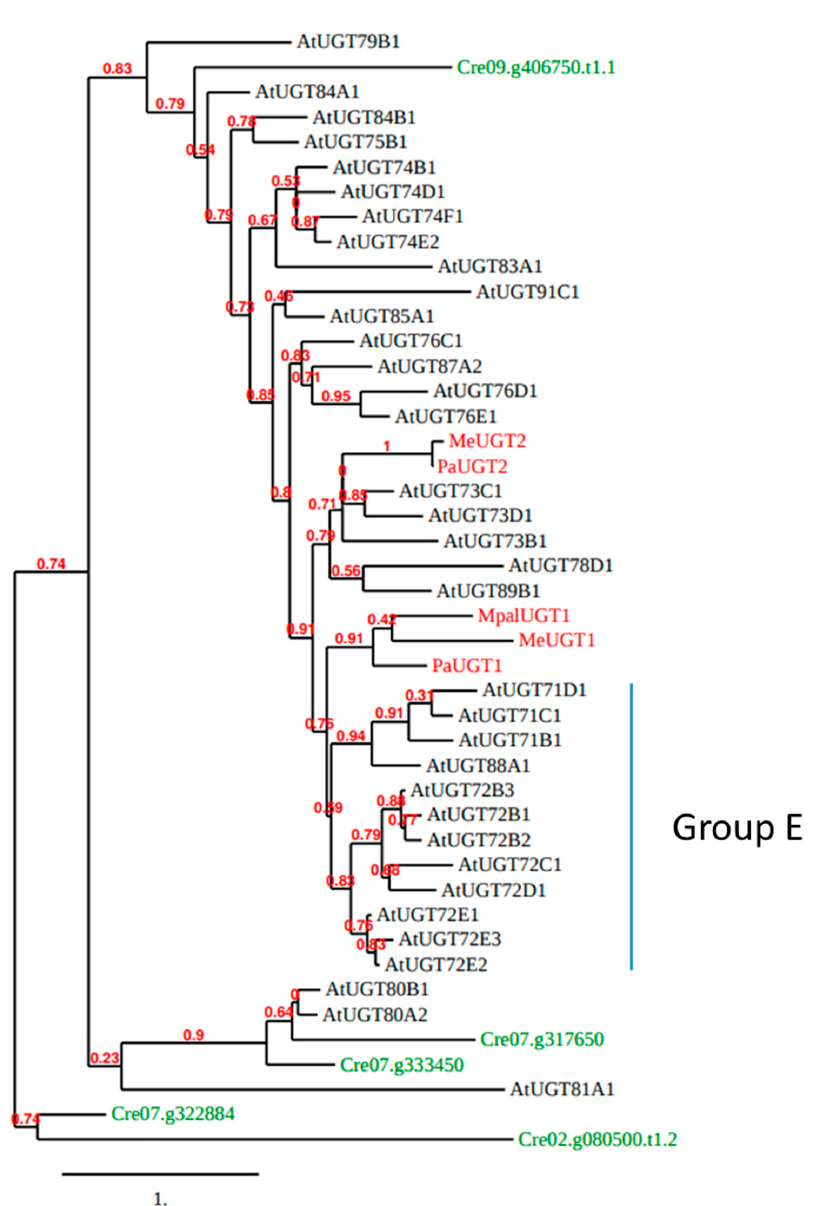
Figure 4. Phylogenetic tree of whole polypeptide sequences of Arabidopsis UGTs (black), five functionally described UGTs (MeUGT1, MeUGT2, MpalUGT1, PaUGT1, and PaUGT2) from 3 species of liverworts ( M. emarginata , M. paleacea , and P. appendiculatum ; red) and the five C. reinhardtii UGTs (green). This tree was generated by the approximate likelihood-ratio test method [56,57]. Scale bar: expected number of amino acid substitutions per